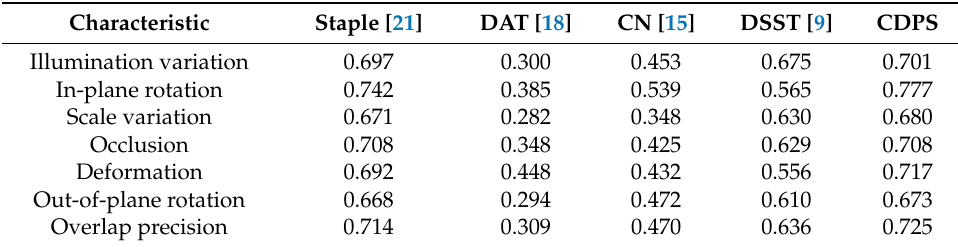
Table 4. Success rates of the different methods.